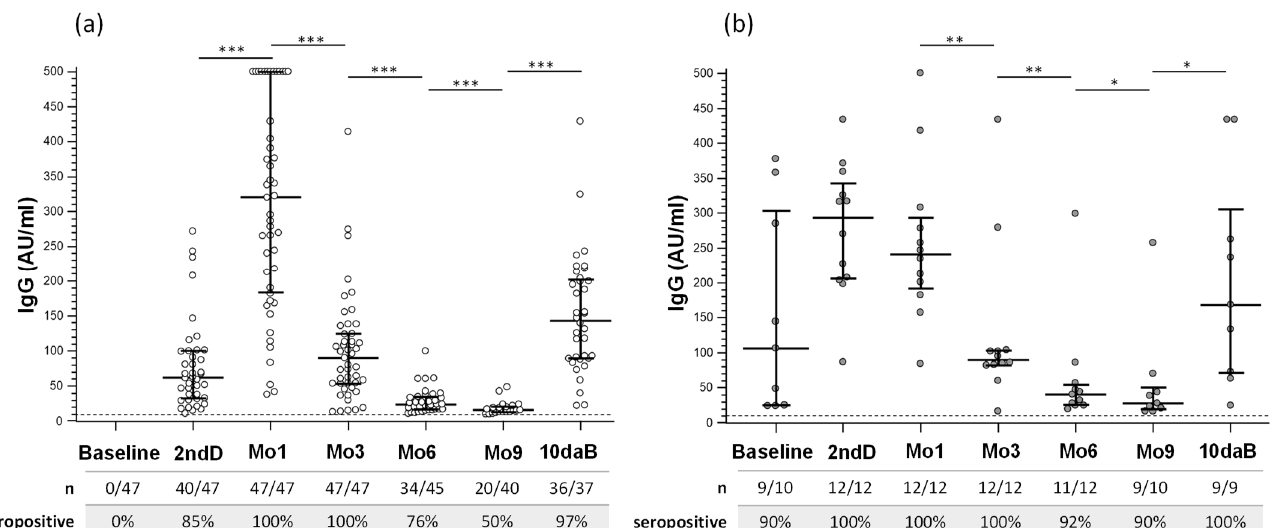
Table 1. Demographic characteristics of the individuals enrolled in the study.